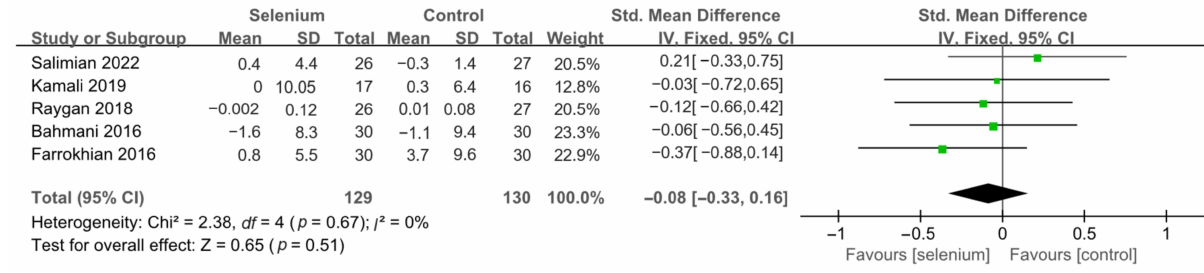
Figure 11. Forest plot of VLDL-C [30,41,44–46].